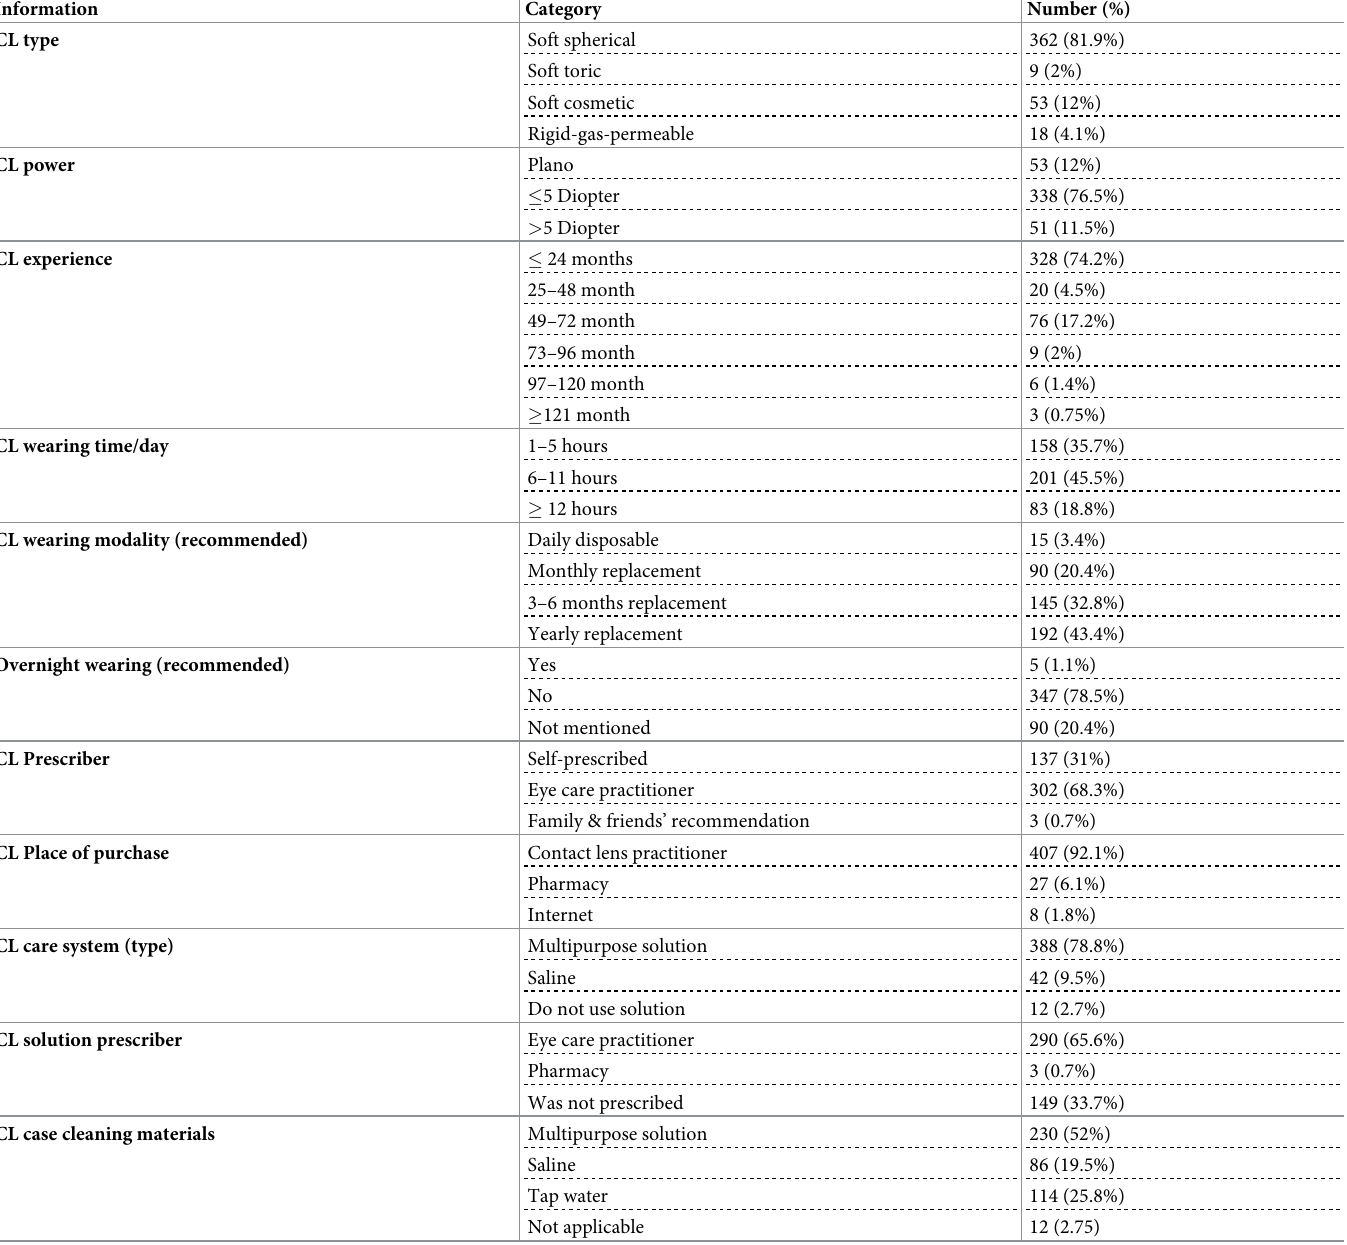
Table 2. Contact Lens (CL) wear profile (n =